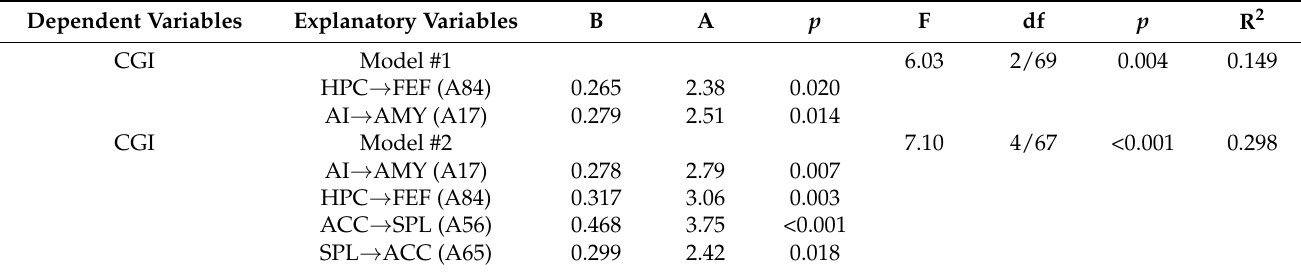
Table 3. Results of multiple regression analysis with the CGI, MDRS and OSOS as dependent variables and connectivity strengths as explanatory